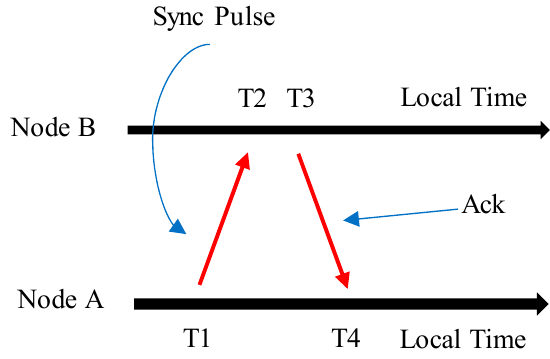
Figure 4. Synchronization between two nodes.